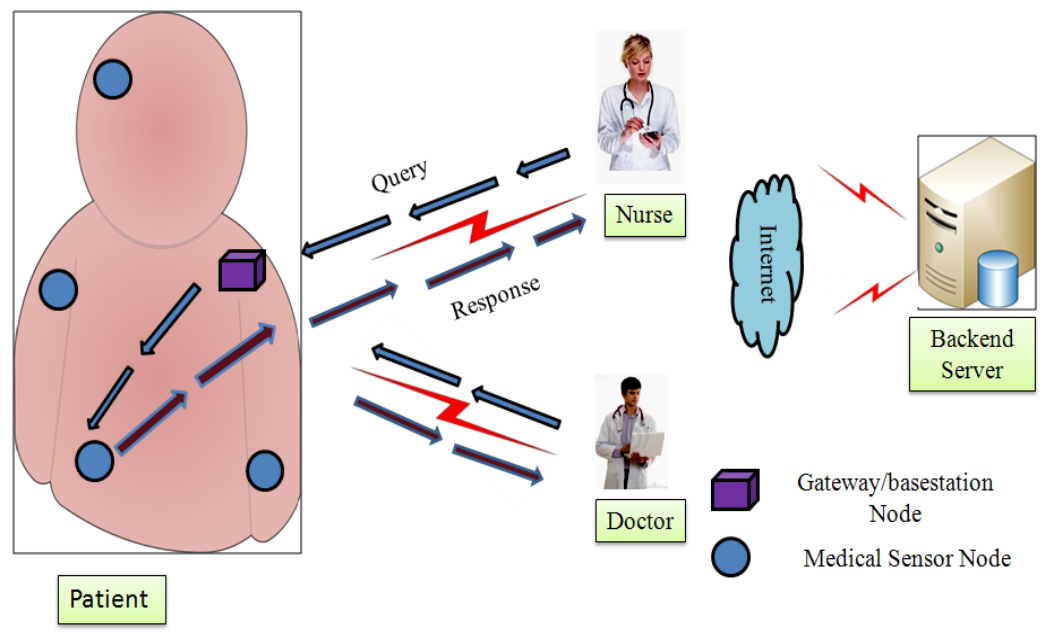
Figure 2. Healthcare architecture for patient